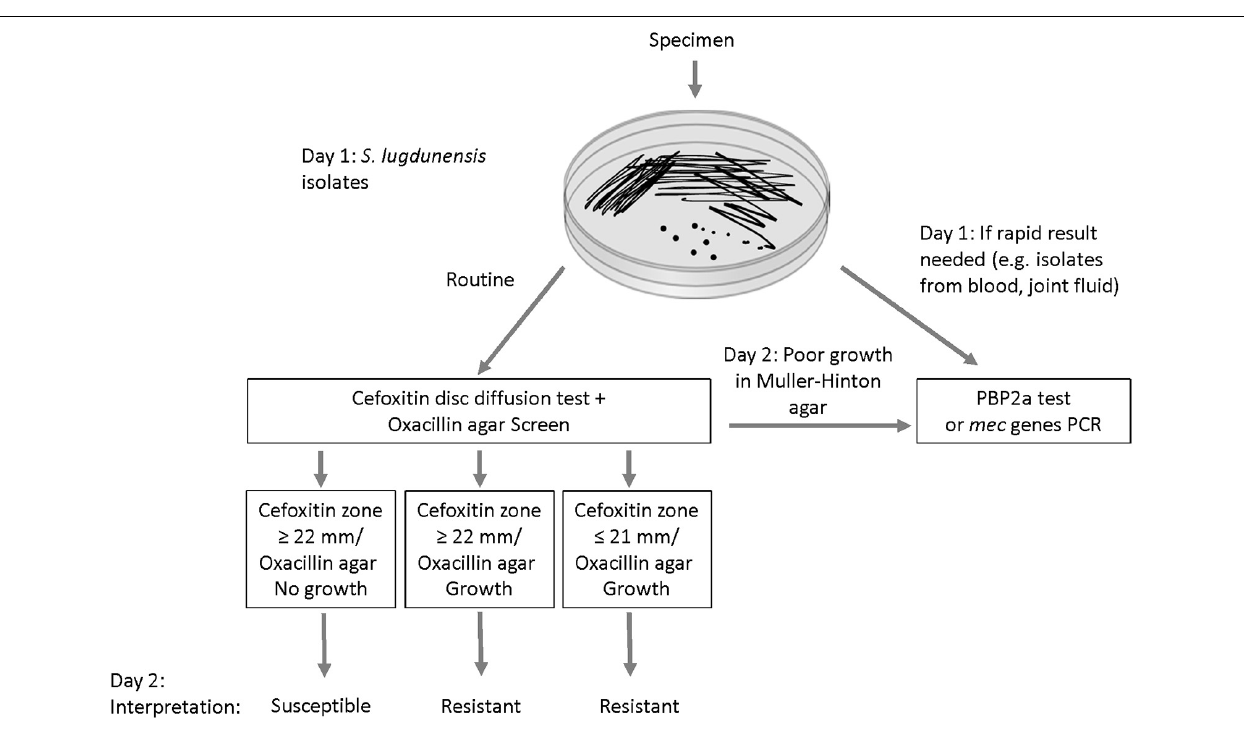
Some of the S. lugdunensis isolates did not grow